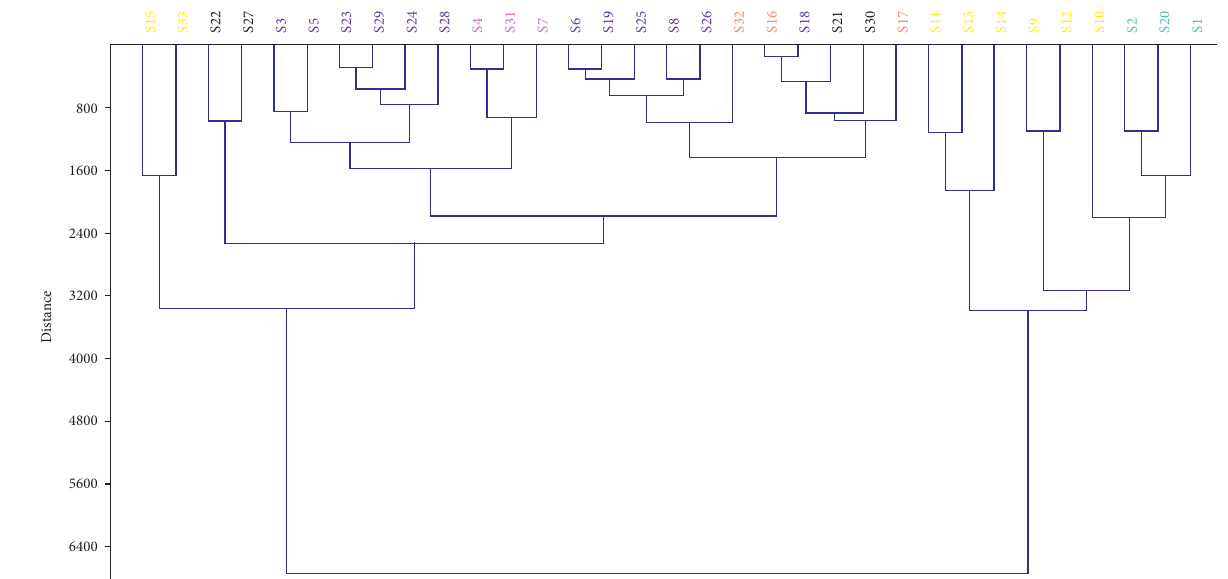
Figure 3: Cluster analysis of 33 S. divaricata